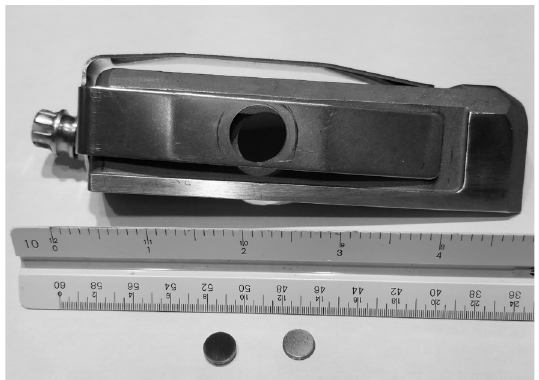
Fig. 5. Fuel channel fastener showing example of cut made to extract the retrospective dosimetry disks for specific activity